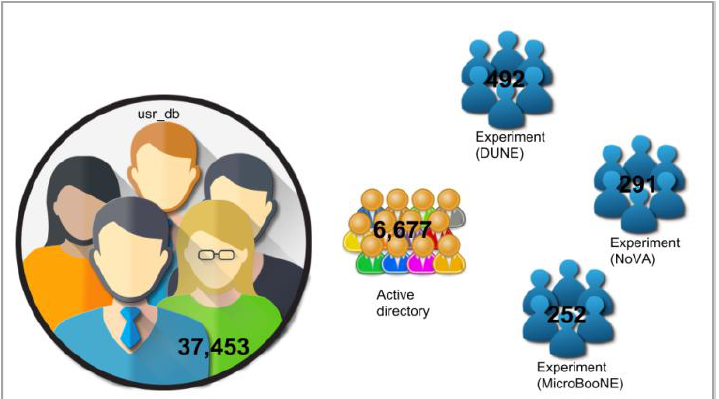
Fig. 1. Groups of users that have been registered in FERRY, from the Fermilab HR database (user_db) to VO